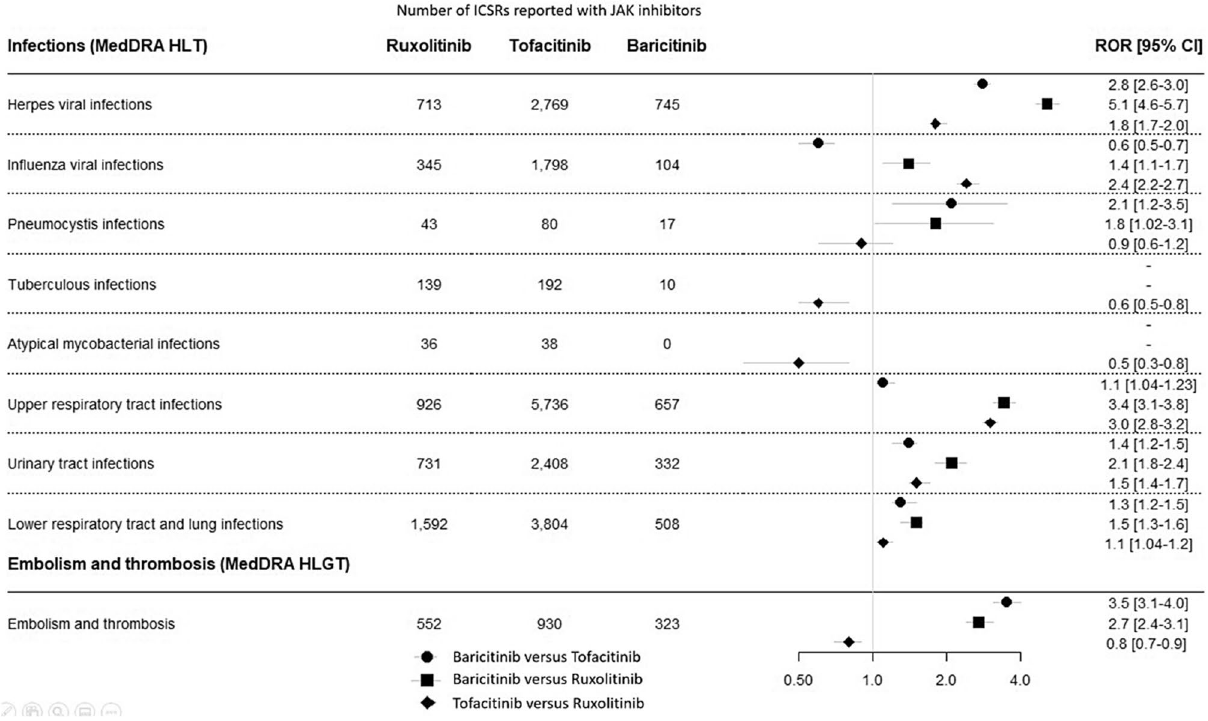
Figure 2. Comparison between the three JAK inhibitors for selected adverse events. ICSR Individual Case Safety Report; ROR [95% CI] reporting odds ratio and 95% confidence interval. MedDRA Medical Dictionary for Regulatory Activities; HLT High Level Term in the MedDRA classification; HLGT High Level Group Term in the MedDRA classification; PT Preferred Term in the MedDRA